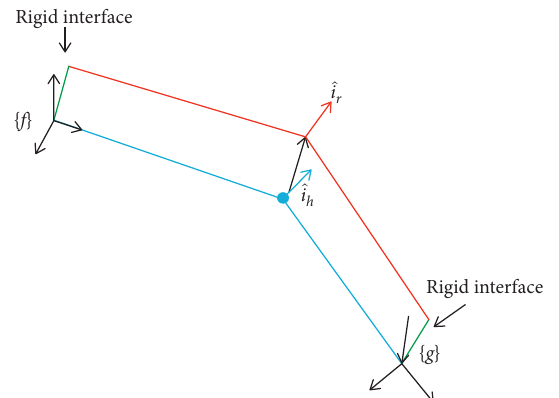
Figure 4: Human-exoskeleton kinematic chain representation [9]. g may be referred to as the body, while f is the reference body. 􏽢 i the IAR of the human, and 􏽢 i r is the IAR of the